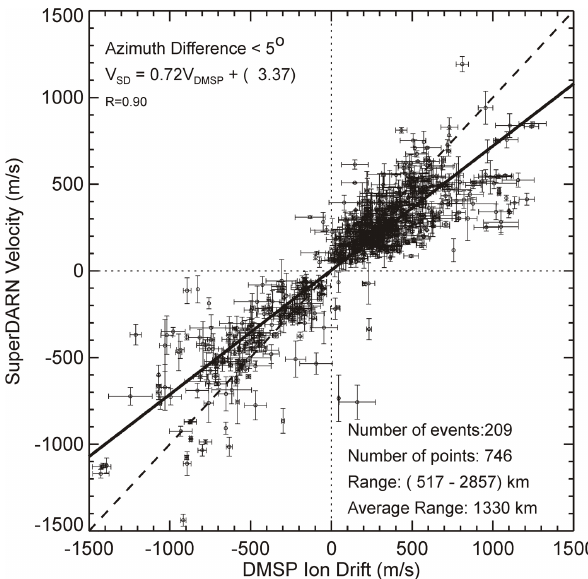
Fig. 6. The same as in Fig. 5 but for 9 radars: Hankasalmi, Pikkvibaer, Stokkseyri, Saskatoon, Kodiak, Halley, Sanae, Syowa- South and Syowa–East and various radar